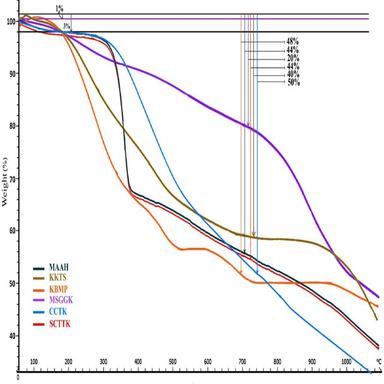
TGA thermogram of monumental brick samples.